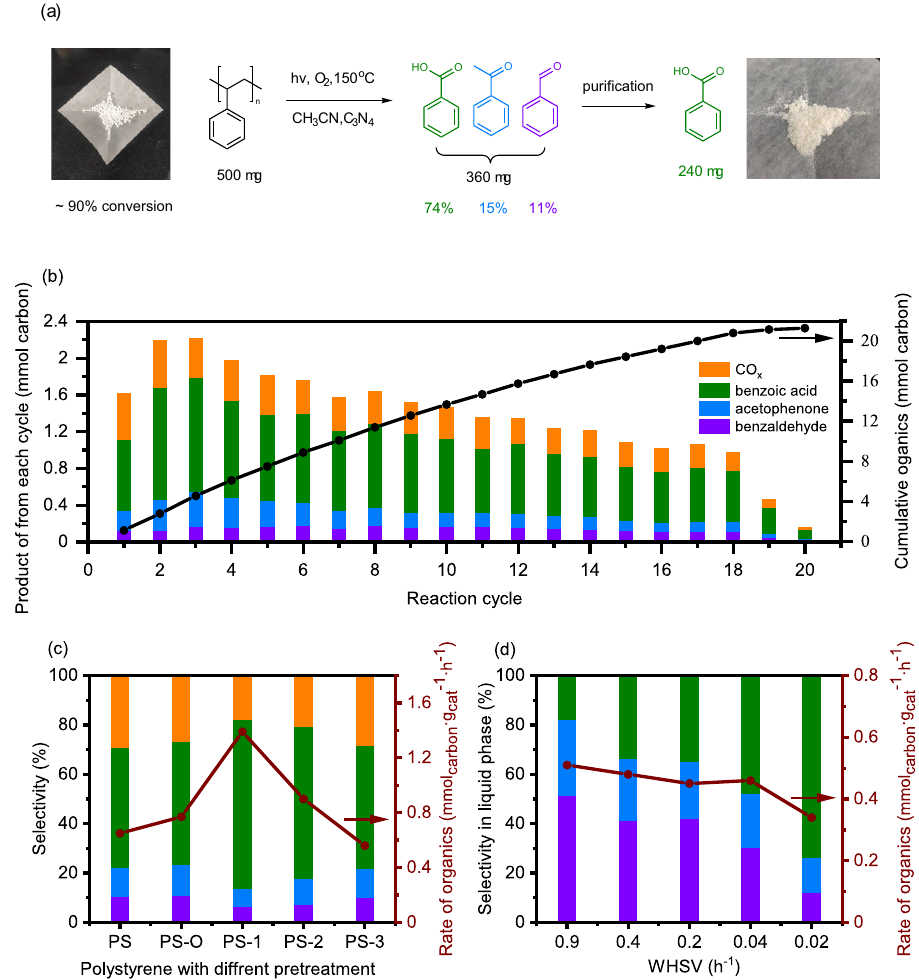
Fig. 3 | Improvement of reaction performances based on the reaction mechanism.a Schematicdiagramoftheconversionexperimentof500mgreal-life PS pellets; ( b ) Conversion of 500mg plastic pellets in 20 reaction cycles, reaction conditions:200mgg-C 3 N 4 ,500mgpellets,40mLacetonitrile,10barO 2 ,irradiated by 300W Xenon lamp at 150°C for 8h in each cycle. The solution is released after each cycle and pure solvent isinjected into the autoclave. c Catalytic performance of polystyrene with different pretreatment, reaction conditions: 50mg g-C 3 N 4 , 20mg polystyrene, 30mL acetonitrile, irradiated by 300W Xenon lamp at 150°C for8h.PS-Owasobtainedfromthermaltreatmentat150°CinacetonitrilewithO 2 ,